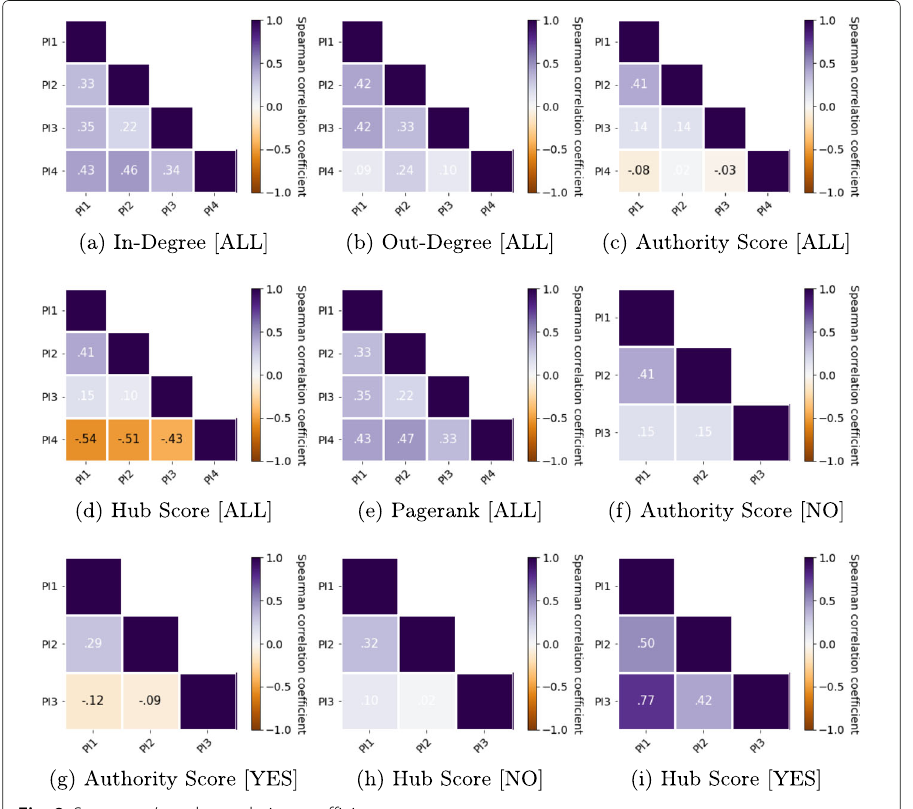
Fig. 8 Spearman’s rank correlation